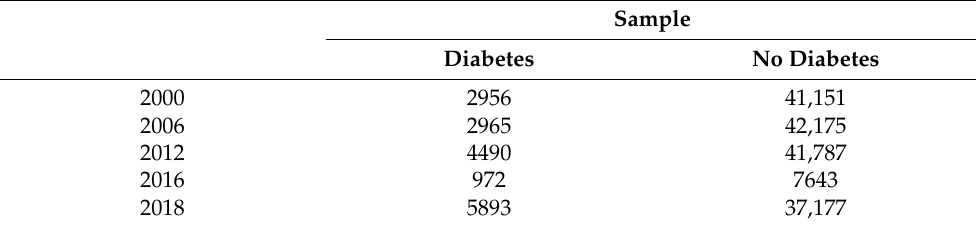
Table 1. The universe of individuals aged 20 years and over in different